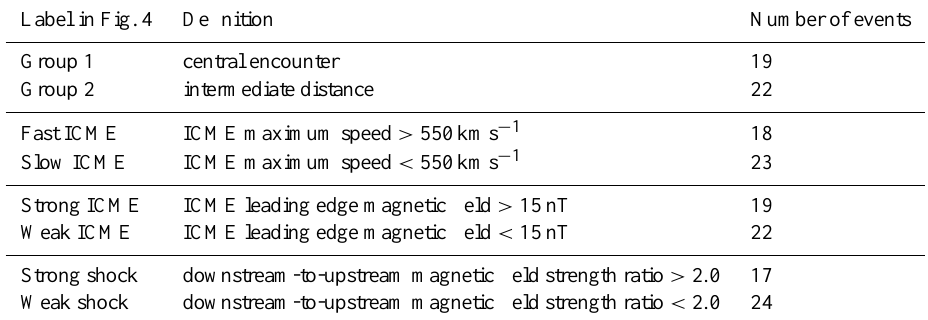
Table 2. Division of events with different criteria. The first column gives the name shown in Fig. 4, the second column the definition, and the last column the number of events with that